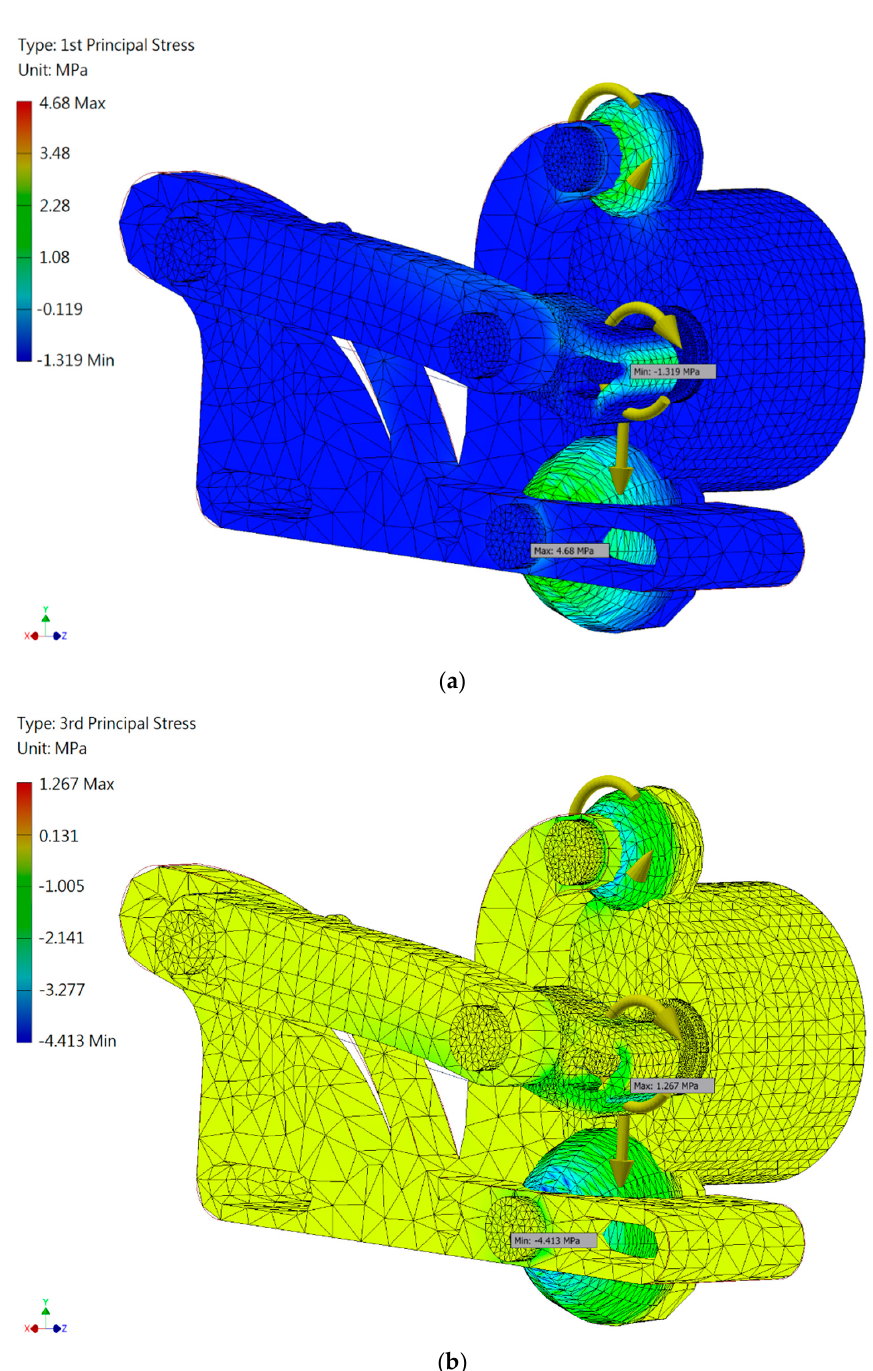
Figure 2. Simulated results: the first principal stress ( a ) and the third principal stress ( b ).